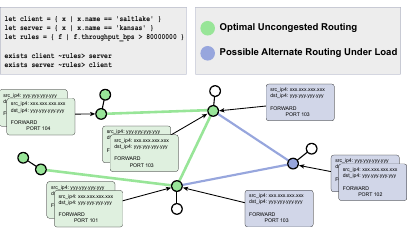
Figure 4. Testbed used to evaluate QoS tuning of Ceph cluster network tra ffi